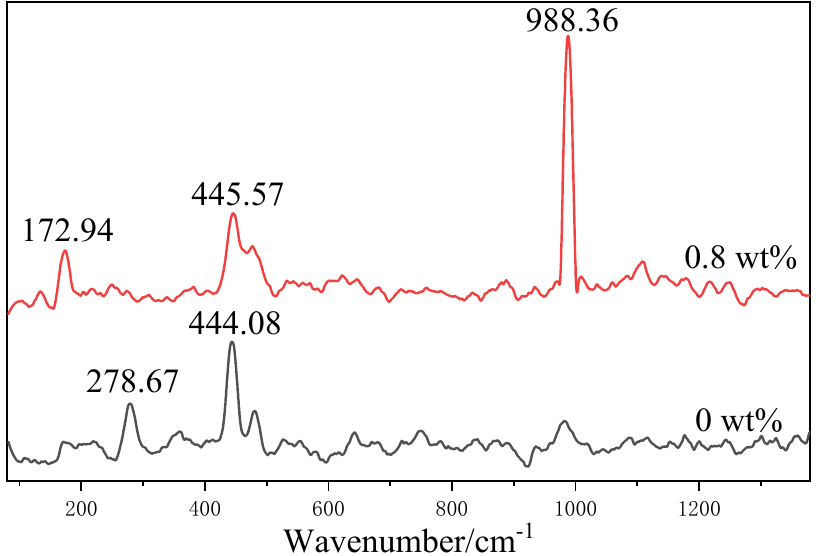
Figure 2. XRD patterns of products with 0 and 0.8 wt% of CS. The Raman spectroscopy results of the products with 0 and 0.8 wt% of CS (Figure 3) were consistent with the XRD-analysis results. In the case of the CS addition, intensive sulfate vibrations (symmetric stretching vibrations) were detected in the sample at 988 cm − 1 . The symmetric and asymmetric stretching vibrations of the sulfate were observed at 100–500 cm − 1 , but these vibrations were indistinguishable from the stretching vibrations of the Mg–O octahedra. Without the addition of CS, the Raman spectra of the samples showed sharp bands of the stretching vibrations of Mg–O at 279 and 444 cm − 1 ; this was in agreement with the results of previous studies on Mg(OH) 2 [31].